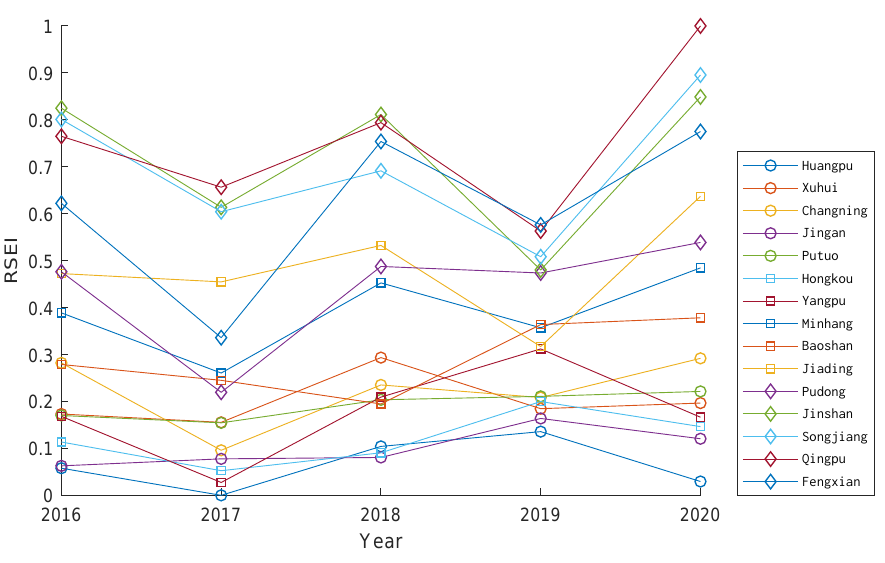
Figure 17. Line chart of RSEI.